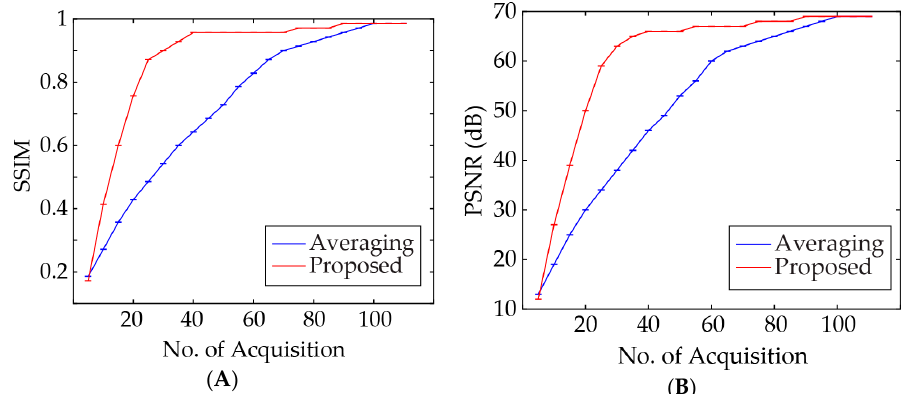
Figure 4. ( A ) Structural similarity index measure (SSIM) and ( B ) peak signal to noise ratio (PSNR) versus the number of acquisitions for the proposed method and conventional averaging method.